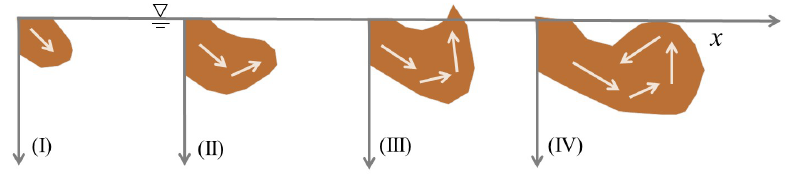
Figure 9. Sketch of the submerged slide’s moving and deforming